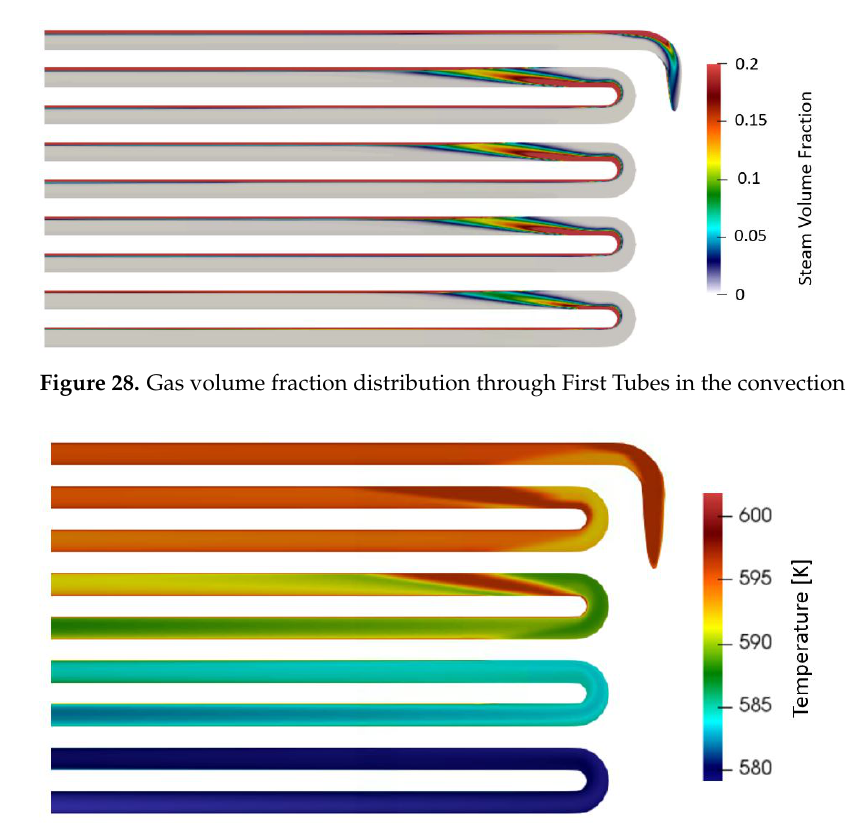
Figure 29. Temperature distribution through First Tubes in the convection